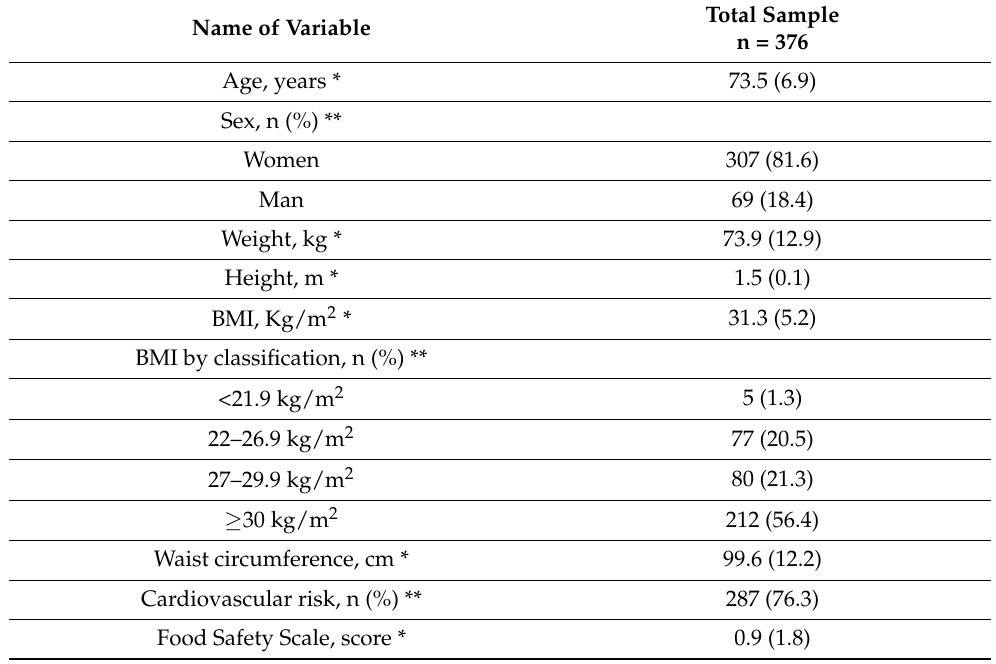
Table 1. Descriptive characteristics of